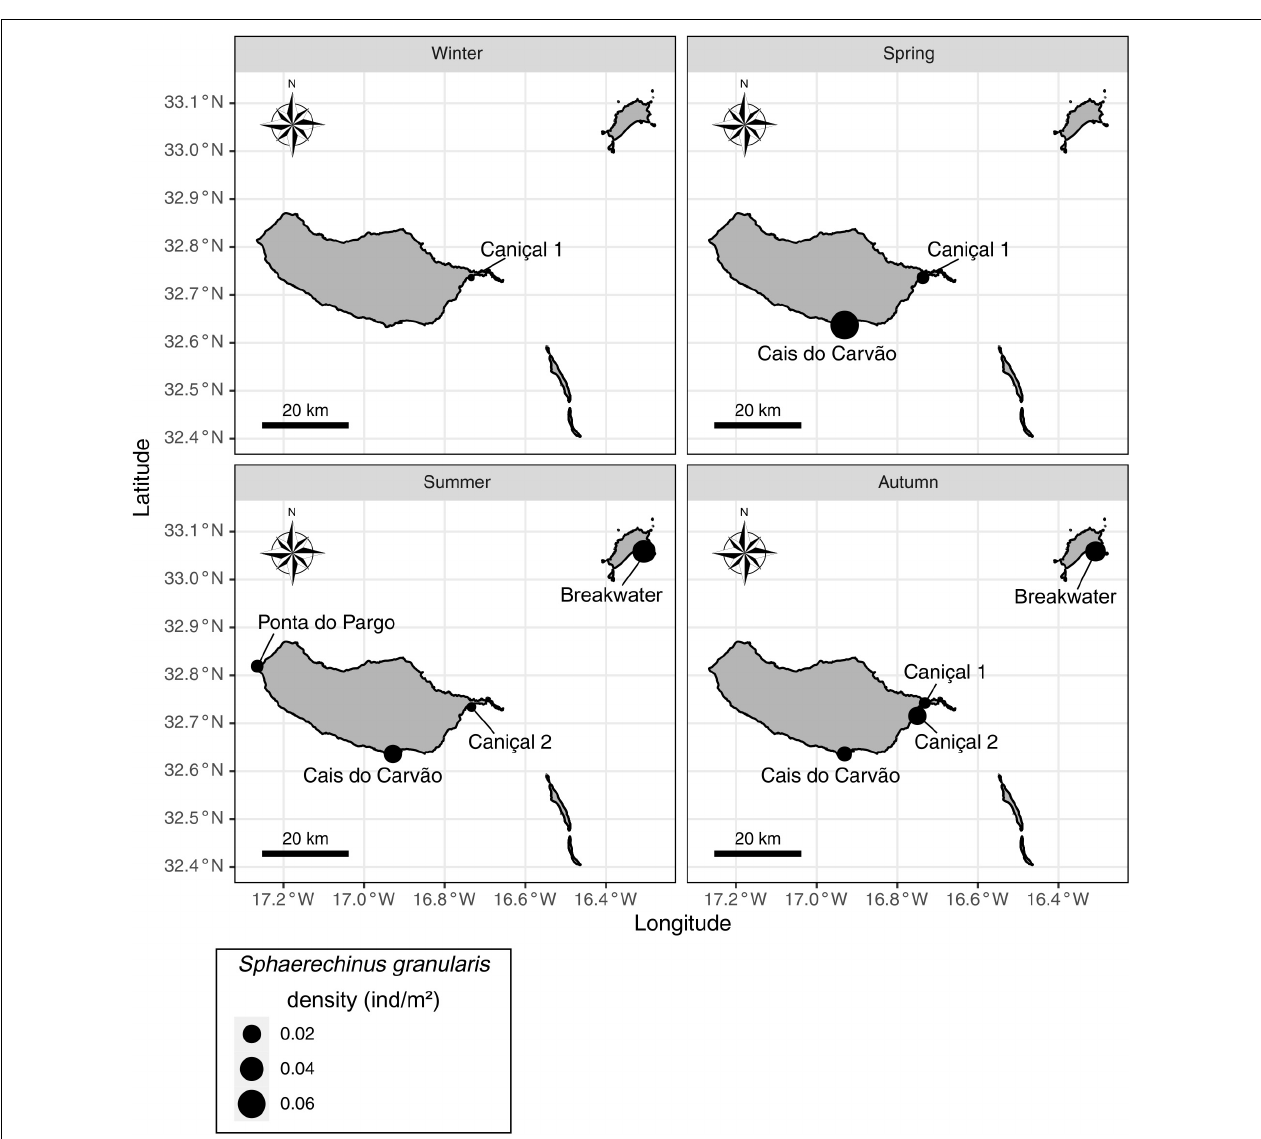
FIGURE 2 | Spharaechinus granularis mean densities (ind./m 2 ) by season in the five sampling locations where the species was recorded in Madeira archipelago.